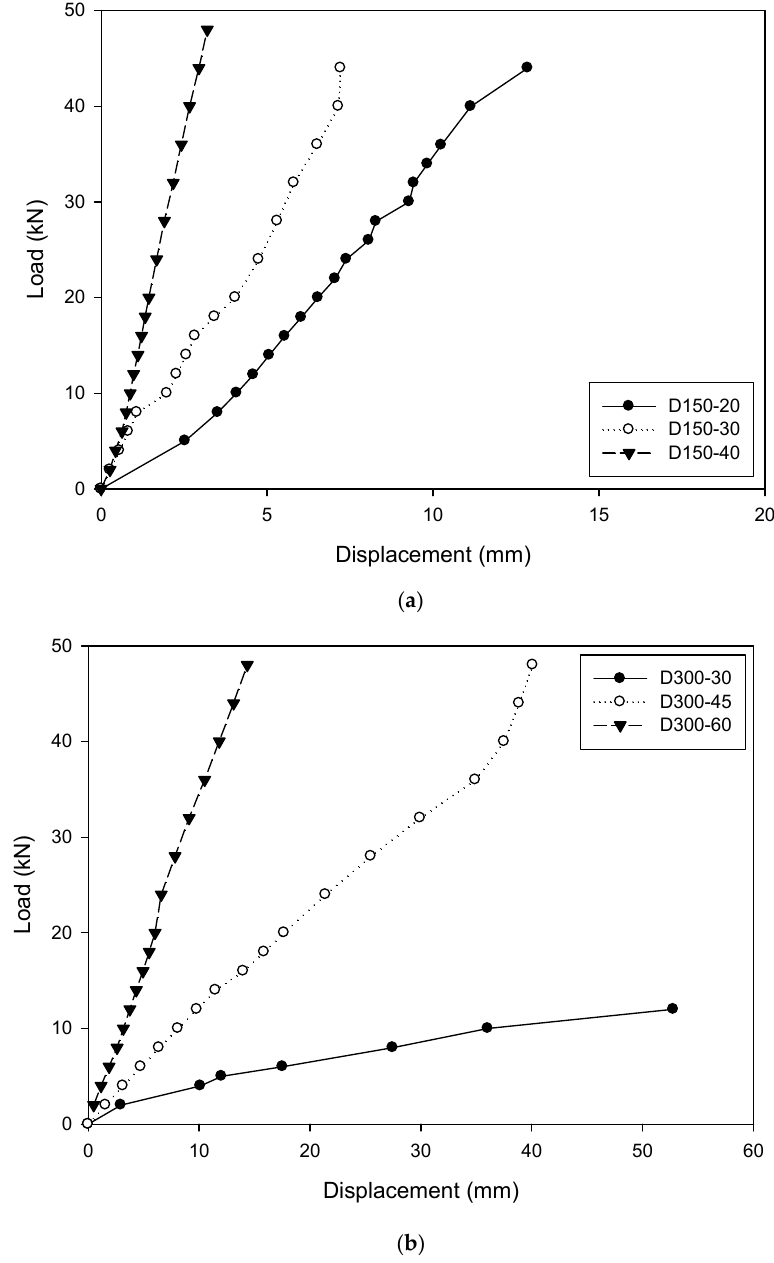
Figure 8. Vertical displacement of the cross arm at the loading point: ( a ) Specimens with the GFRP tube diameter of 150 mm; ( b ) specimens with the GFRP tube diameter of 300 mm.